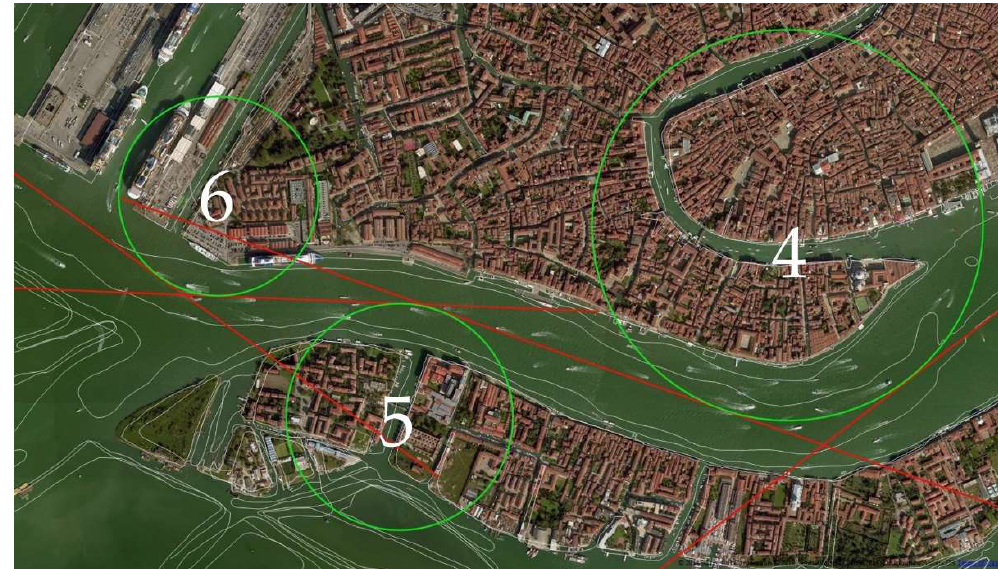
Figure 5. Manoeuvring scheme in the Venetian Canal.